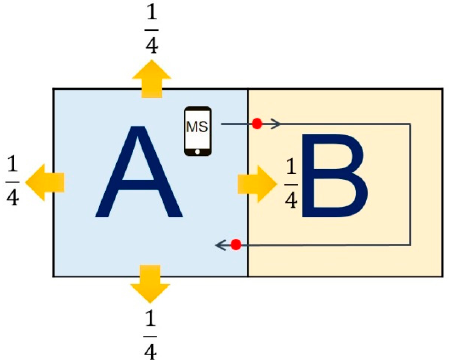
Figure 3. Symmetric random walk mobility model.